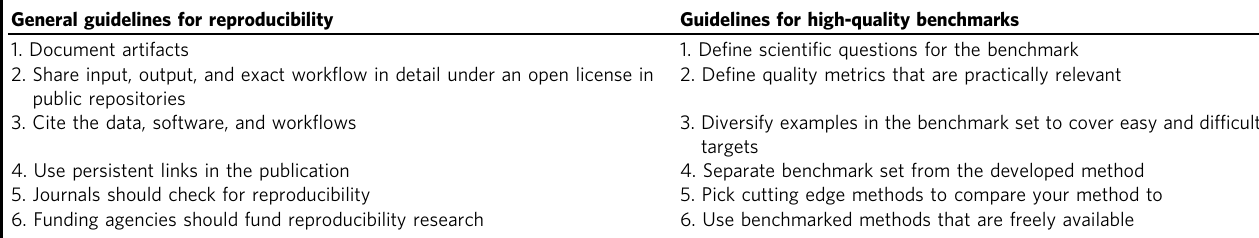
Table 3 Guidelines for reproducible research and for the development of high-quality